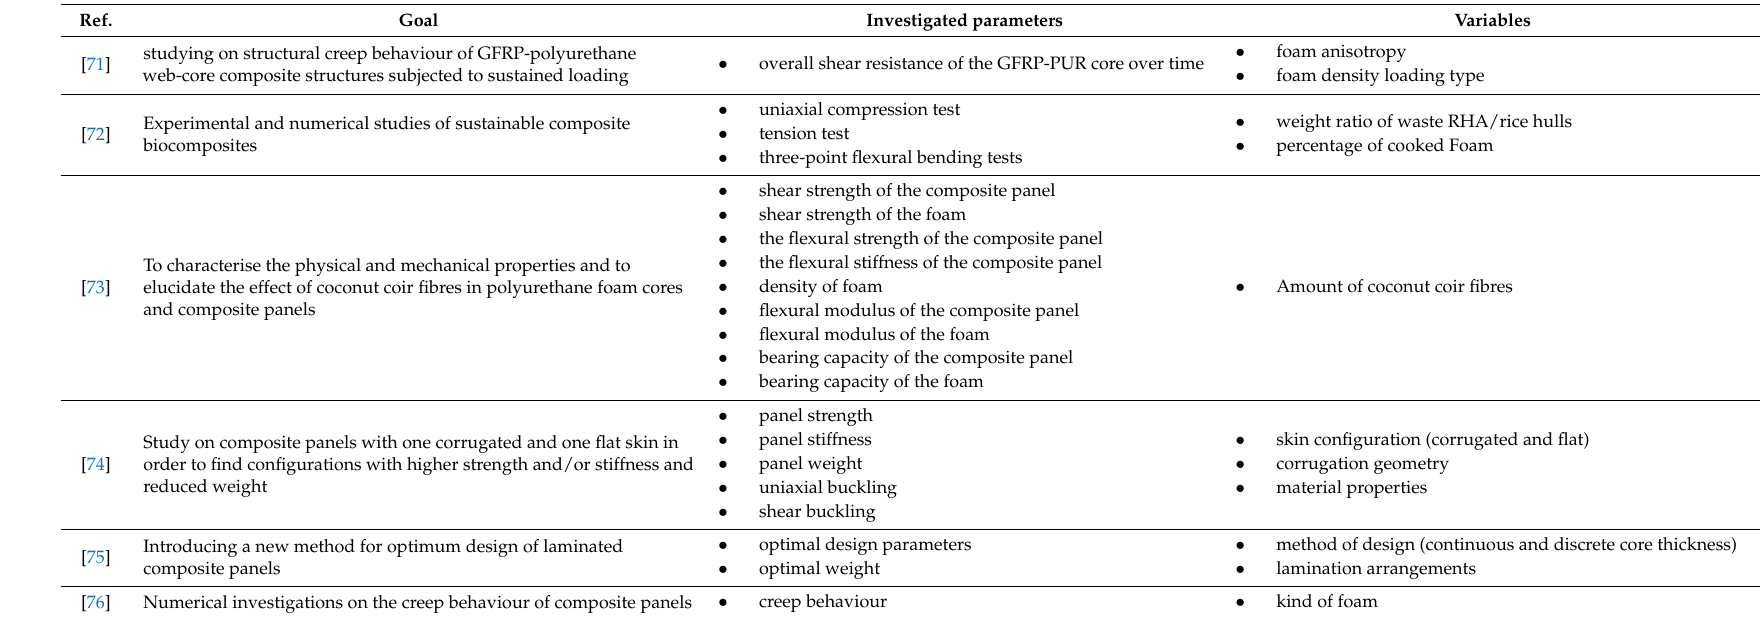
Table 5. Summary of references